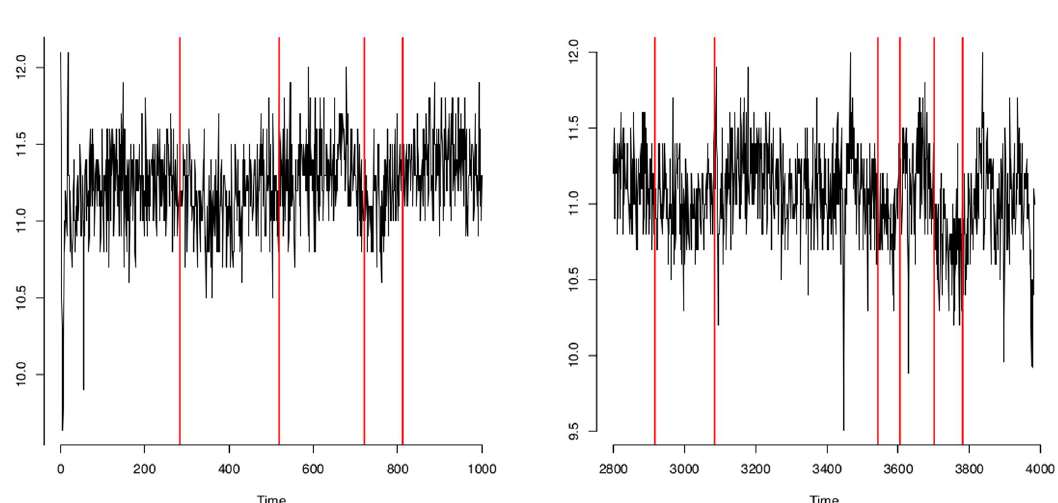
Fig 14. Change-point locations identified using ARMA(1,1) model displayed with the original well-log data at two different time points. (Left) change-point locations using ARMA(1,1) model in well-log data at time points 1 to 1000; (right) change-point locations using ARMA(1,1) model in well-log data after time point